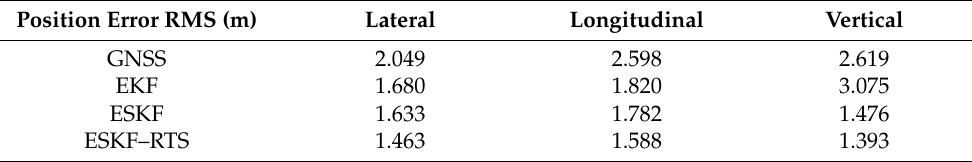
Table 2. RMS values of localization errors for different algorithms (Oval).